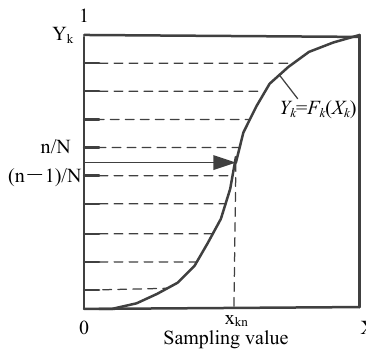
Figure 7. Schematic of LHS.